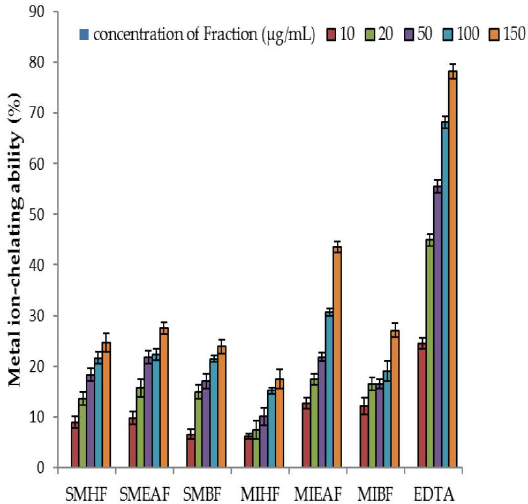
Figure 3. Metal ion chelating property of fractions of S. mombin and M. indica leaves. Legends: SMHF: S. mombin n -hexane fraction; SMEAF: S. mombin ethyl acetate fraction; SMBF: S. mombin n -butanol fraction; MIHF: M. indica n -hexane fraction; MIEAF: M. indica ethyl acetate fraction; MIBF: M. indica n -butanol fraction; EDTA: ethylenediaminetetraacetic acid.